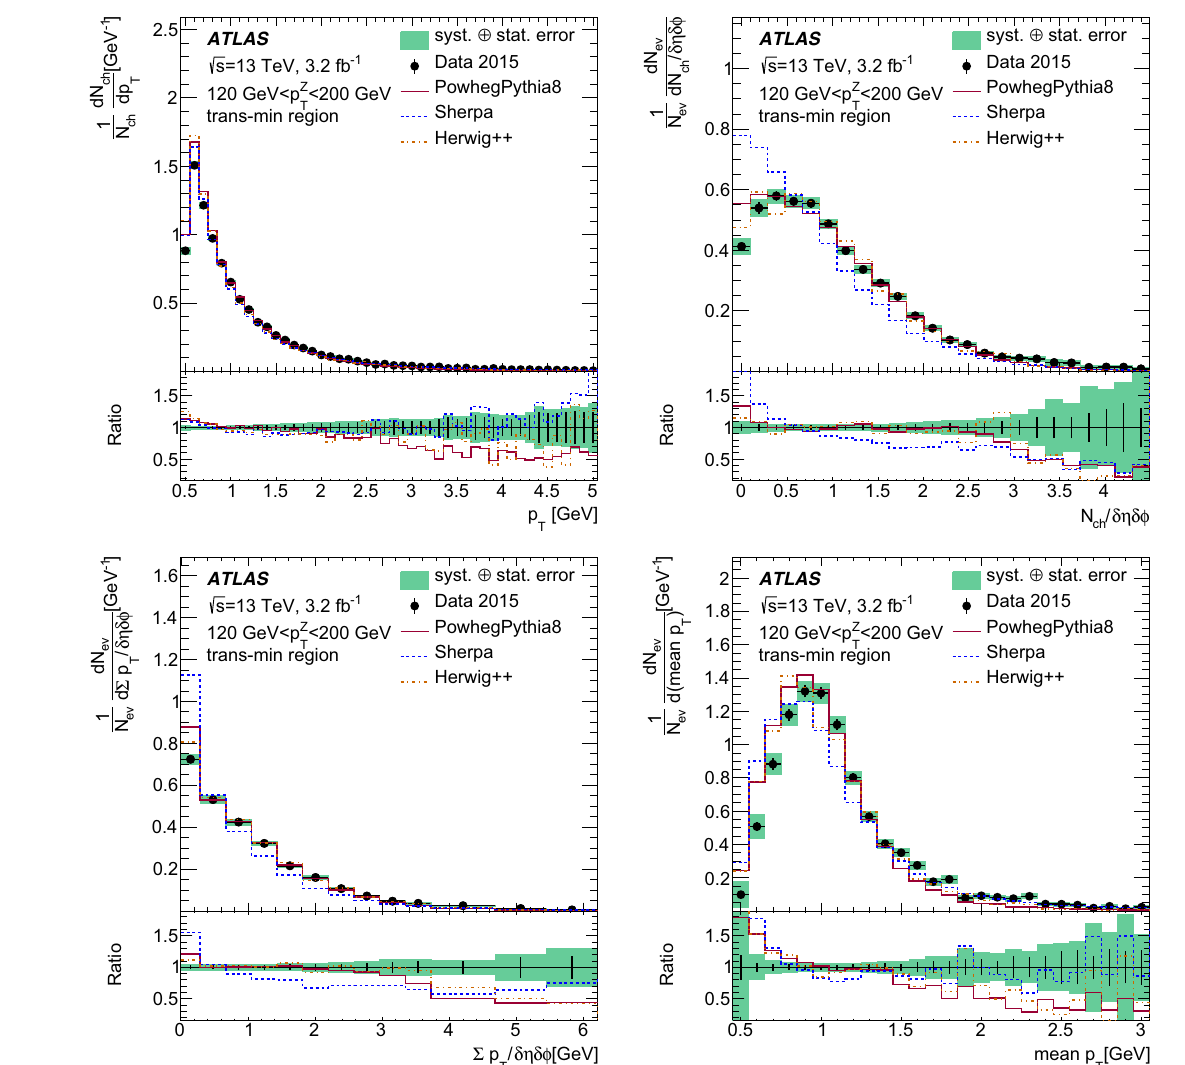
< 200 GeV. Predictions of Powheg + Pythia , events with 120 < p Z T Sherpa , and Herwig++ are compared with the data. The ratios shown are predictions over